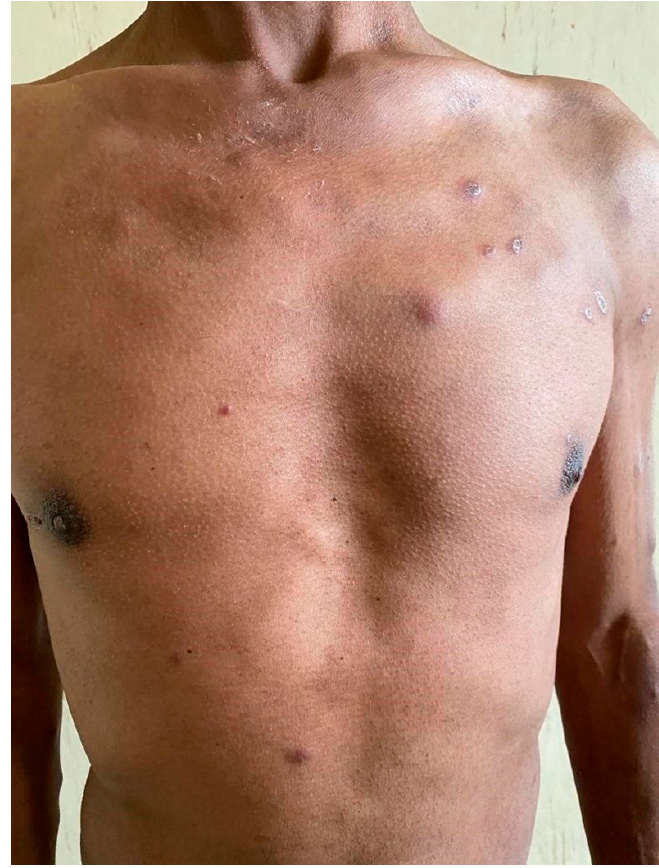
Figure 1. Patient’s torso with lesions at different stages: skin-coloured papules, subcutaneous nodules and plaques with a necrotic centre.